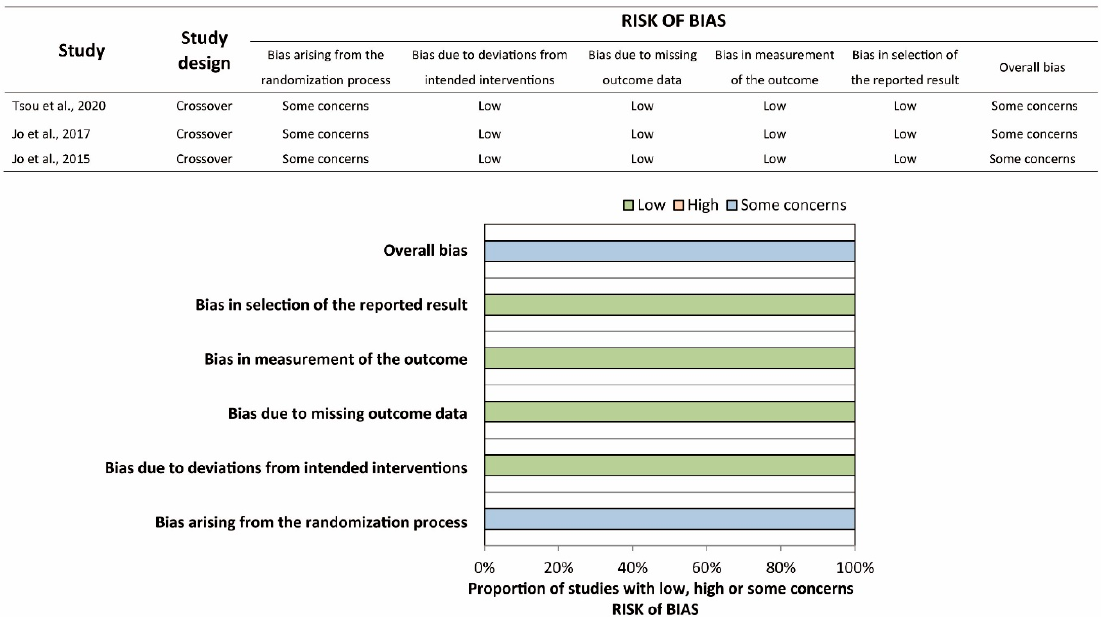
Figure 2. Risk-of-bias summary, and graph of chest-compression depth and proportion of complete chest recoil.